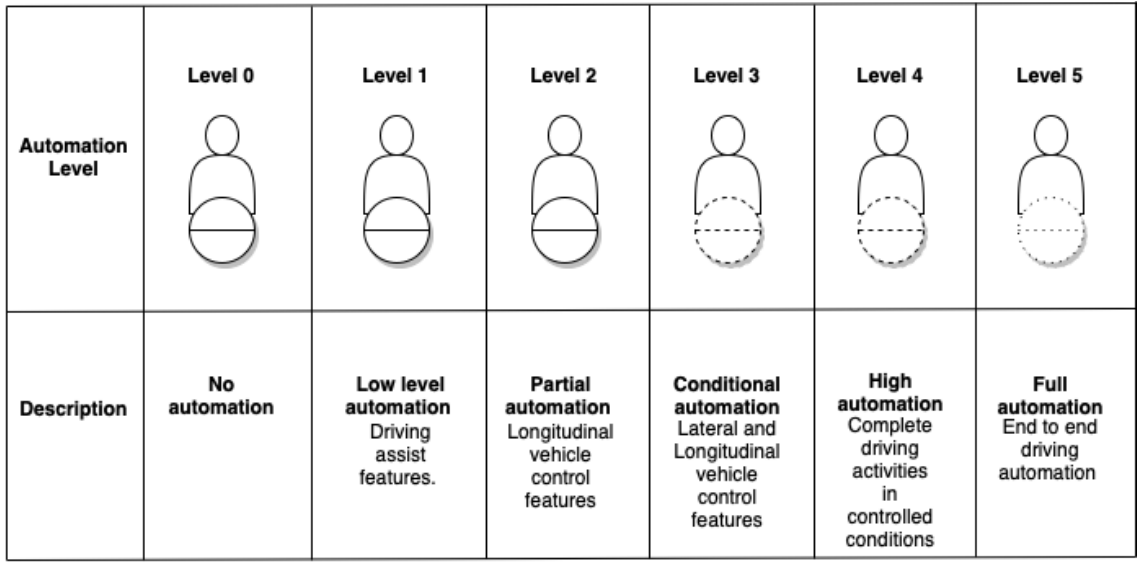
Figure 1. An illustration of SAE levels of automation.